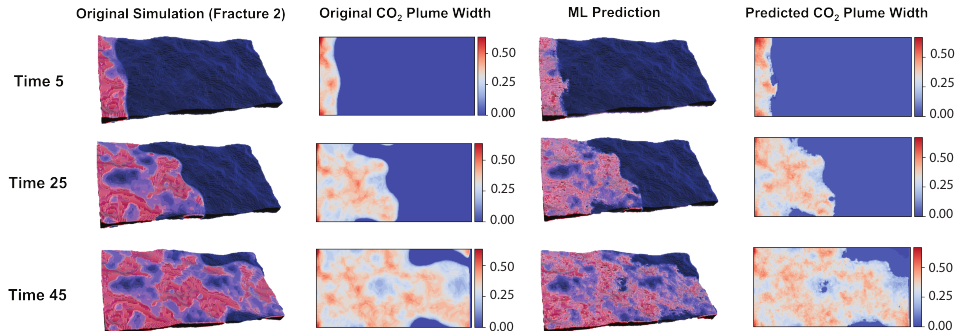
Figure 6. Results of the ML prediction in Fracture 2 for timesteps 5k, 25k, and 45k. Average CO 2 saturation accuracy across all timesteps is 95.94%.